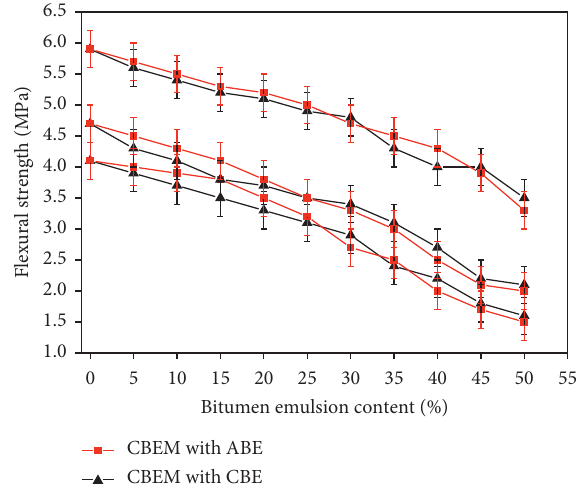
Figure 5: Influences of bitumen emulsion content on the flexural strength.